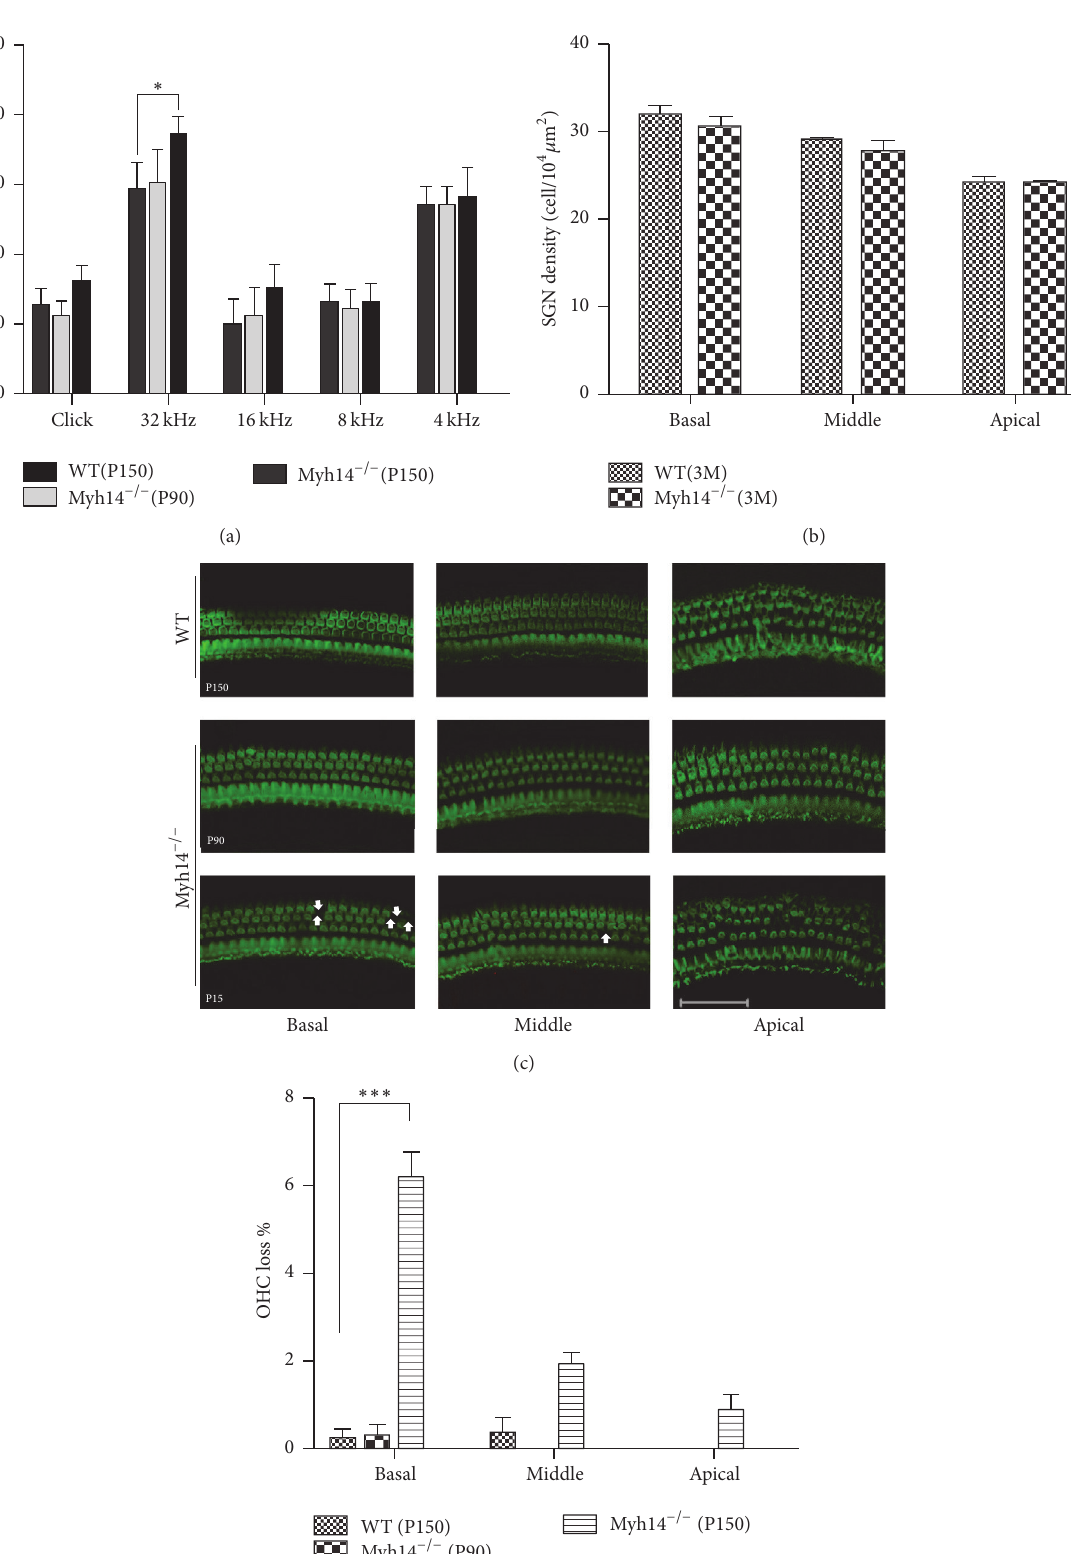
Figure 4: ABR measurement and cell loss patterns in cochleae of the mutant mice. (a) ABR threshold between control and Myh14 −/− mice ( 𝑛 = 10 for each group). ∗ 𝑃 < 0.05 compared to the controls. (b) No significant difference in the SGN density between wild type and mutant mice. (c) Hair cell loss (white arrows) was found in 5-month-old experimental groups ( 𝑛 = 8 ). (d) Quantifications of OHC loss at specific locations in control and experimental groups. ∗∗∗ 𝑃 < 0.001 compared to the control